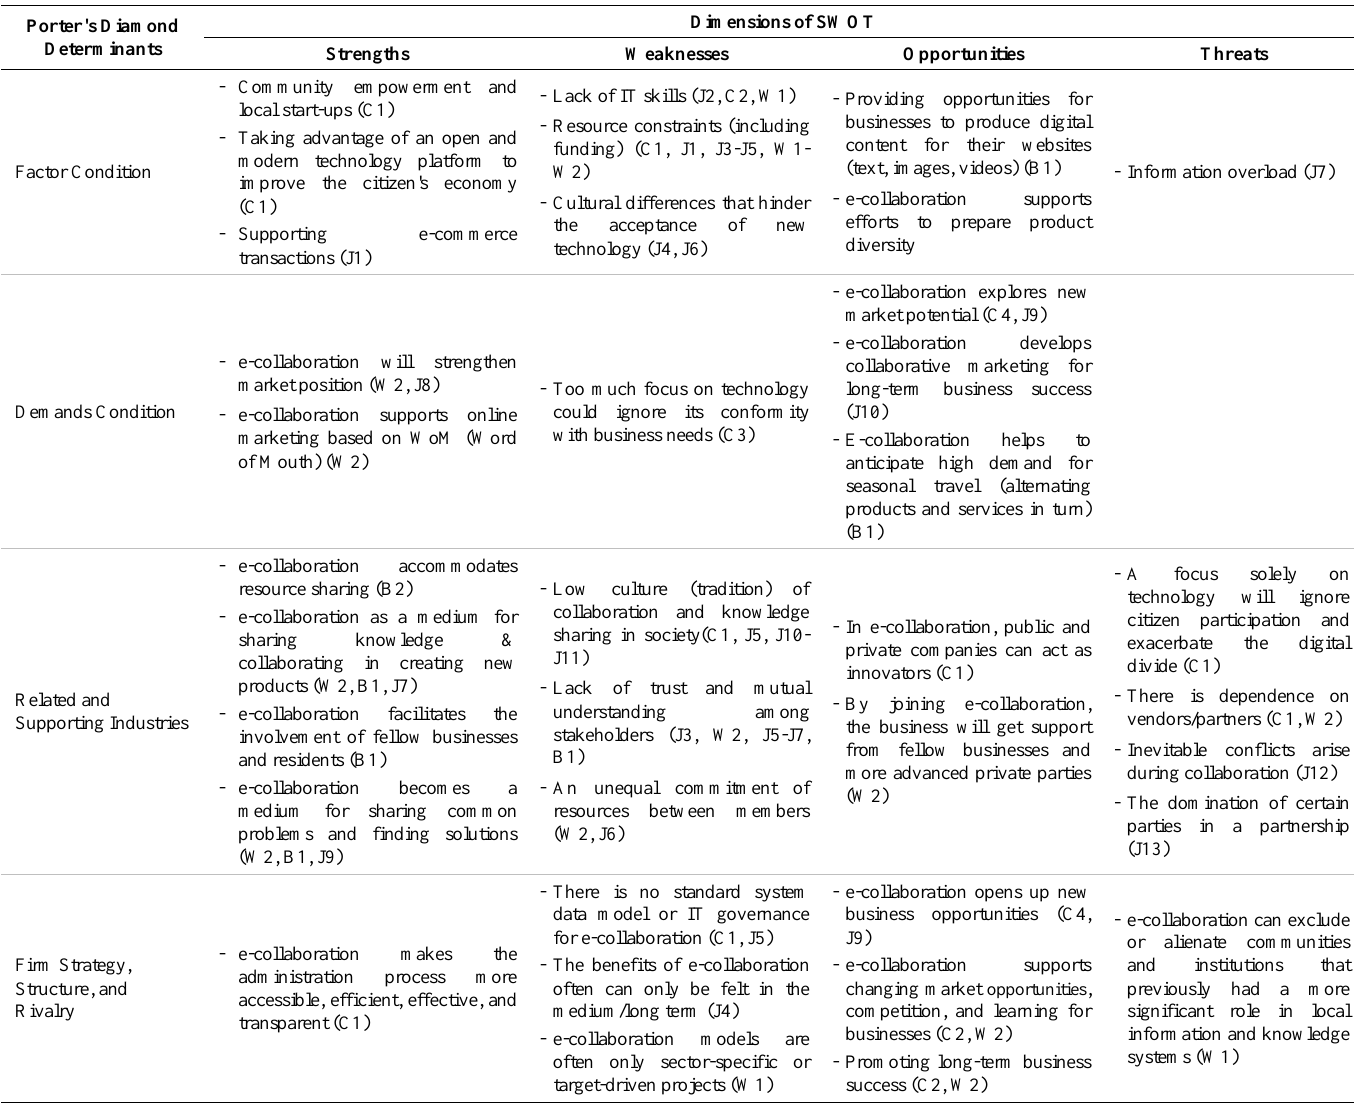
Table 4. Dimensions of SWOT vs. Porter's Diamond